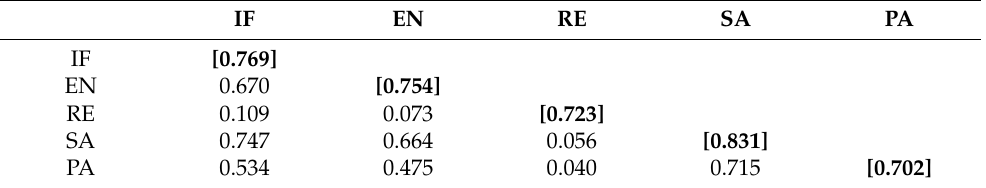
Table 6. Discriminant validity